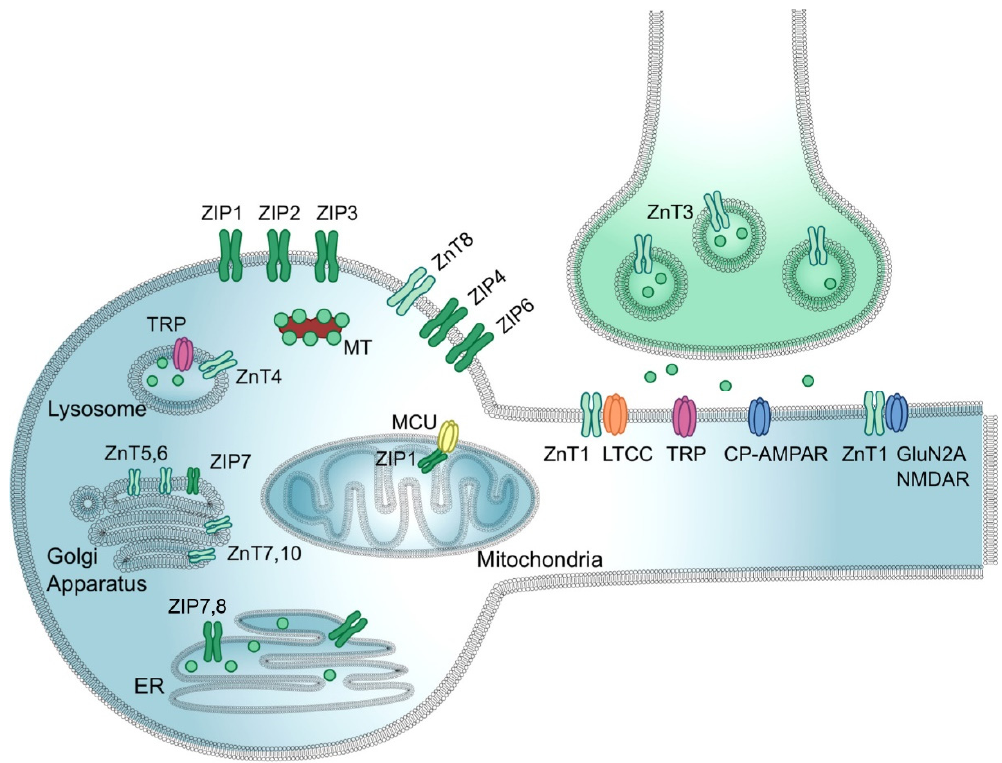
Figure 2. Zinc transport in neurons. Zn 2+ is loaded into presynaptic vesicles via ZnT3, released into the synaptic cleft, and conducted to the cytosol of a postsynaptic neuron via L-type calcium channels (LTCC), transient receptor potential channels (TRP), NMDA receptors, and calcium-permeable AMPA receptor (CP-AMPAR). Within the neuron, Zn 2+ uptake to/release from specific organelles is mediated by organelle-specific ZIPs and ZnTs. Zn 2+ import into mitochondrial matrix is mediated by mitochondrial Ca 2+ /cation uniporter (MCU) coupled with ZIP1. Free Zn 2+ concertation within the cytosol is buffered by metallothioneins (MT). The figure was adapted from Krall et al. [86] and replicated with permission from Elsevier Ltd., license #5203200109216, obtained on 6 December 2021.